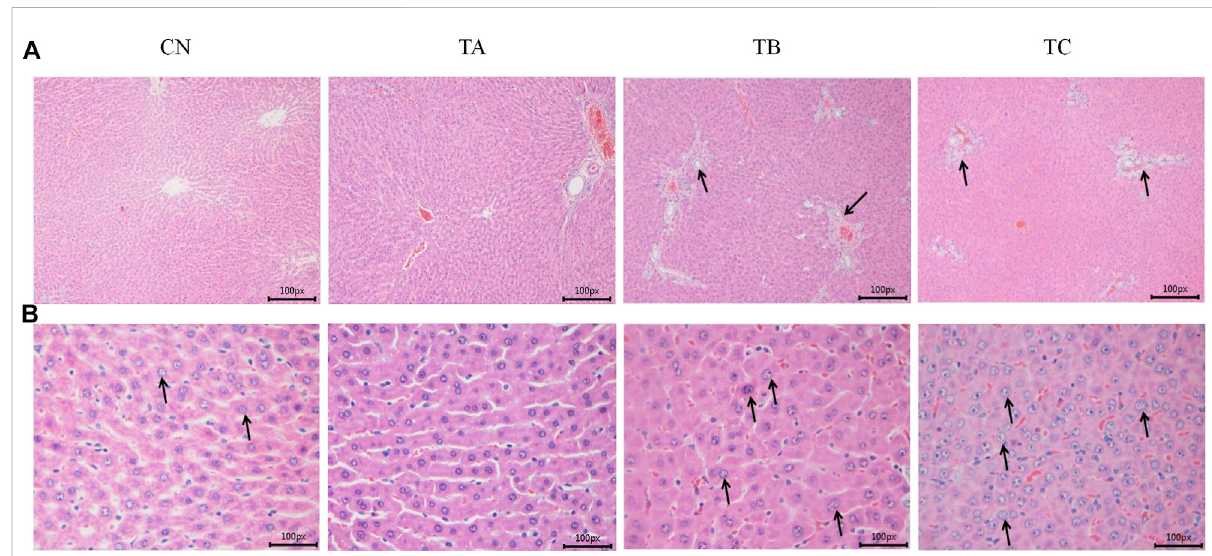
FIGURE 4 The representative histopathological sections of rat liver at the end of the treatment period. (A) The CN and TA rats liver showing normal hepatocytesandhepaticvasculature;TheTBandTCratsliverrshowingbileductproliferationandkaryomegalyofhepatocytes(×100magni fi cation). (B) The CN and TA rats liver showing normal hepatocytes and hepatic vasculature; The TB and TC rats liver showing bile duct proliferation and karyomegaly of hepatocytes (×400 magni fi